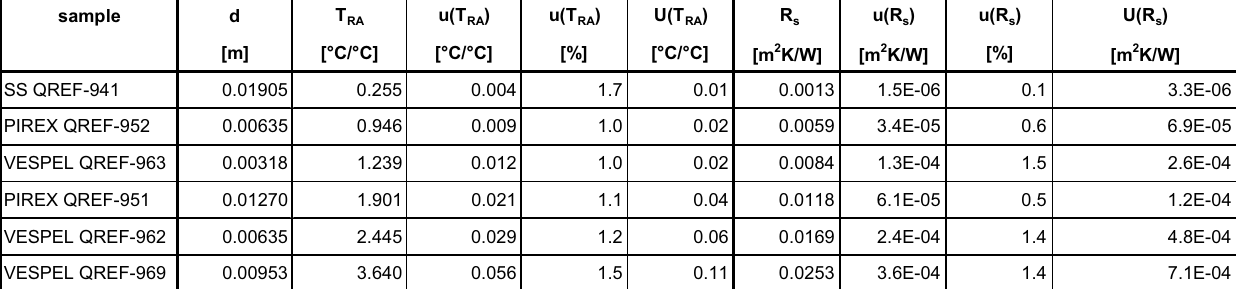
Table 2. Synthesis of the calibration data obtained in correspondence to the reference materials.